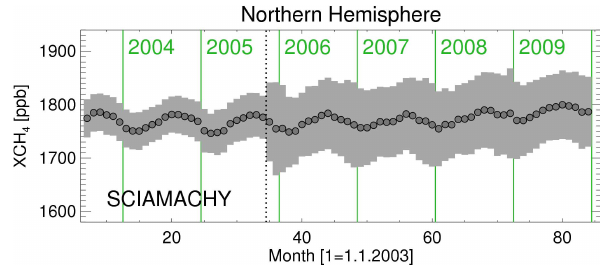
Fig. 12. Monthly means of northern hemispheric SCIA- MACHY WFMDv2.0.2 XCH 4 and corresponding standard devia- tions demonstrating that the scatter since the pixel mask alteration at the end of October 2005 is on average about twice as large. Never- theless, the seasonal cycle of the monthly means can still be clearly observed.